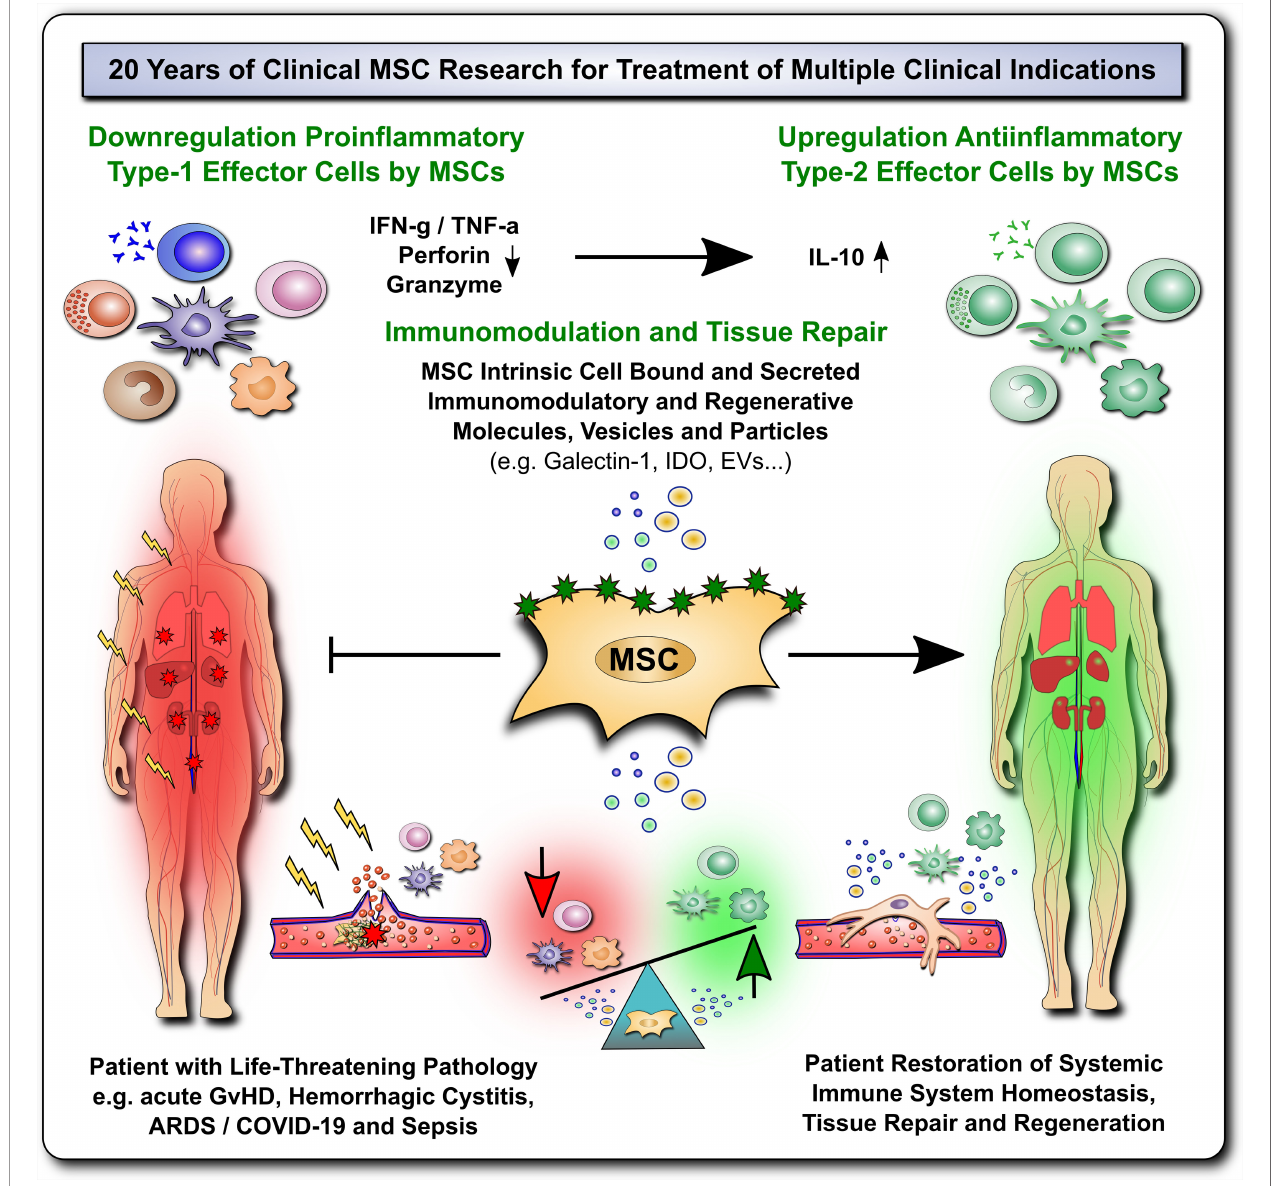
FIGURE 1 | 20 Years of Clinical MSC Research for Treatment for Multiple Life-Threatening Clinical Indications. The past 20 years of clinical mesenchymal stromal cell (MSC) research have shown that these cells can elicit profound immunomodulation and tissue repair upon therapeutic transfer into severely ill patients with multiple life-threatening clinical indications, such as acute Graft-versus-Host Disease (GvHD), Hemorrhagic Cystitis, Acute Respiratory Distress Syndrome (ARDS), Coronavirus 2019 Induced Disease (COVID-19) and Sepsis. This presumably occurs due to down-regulation of proin fl ammatory type-1 effector cells and upregulation of anti-in fl ammatory type-2 effector cells by MSCs through multiple MSC intrinsic cell bound and secreted immunomodulatory and regenerative mediators that restore and promote the patients' immune system homeostasis, tissue repair and